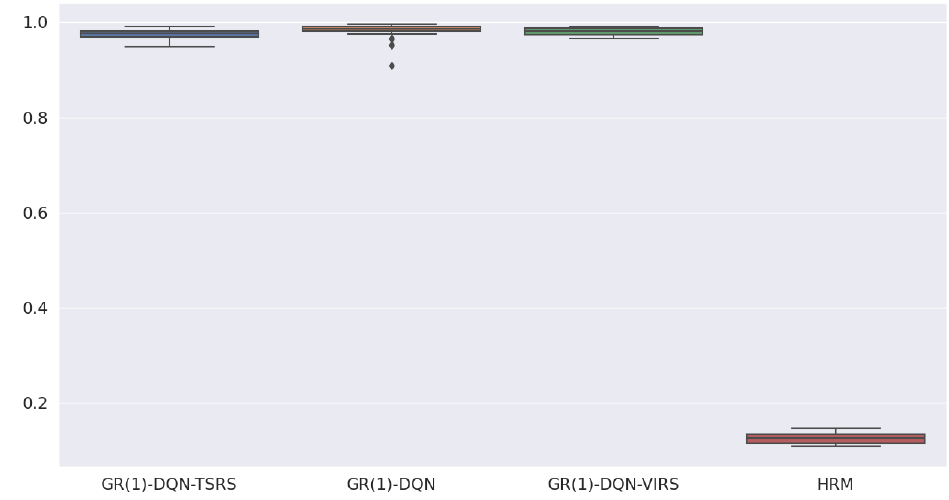
Figure 8. Box plot of learning curve for ϕ 1 under the same environment.